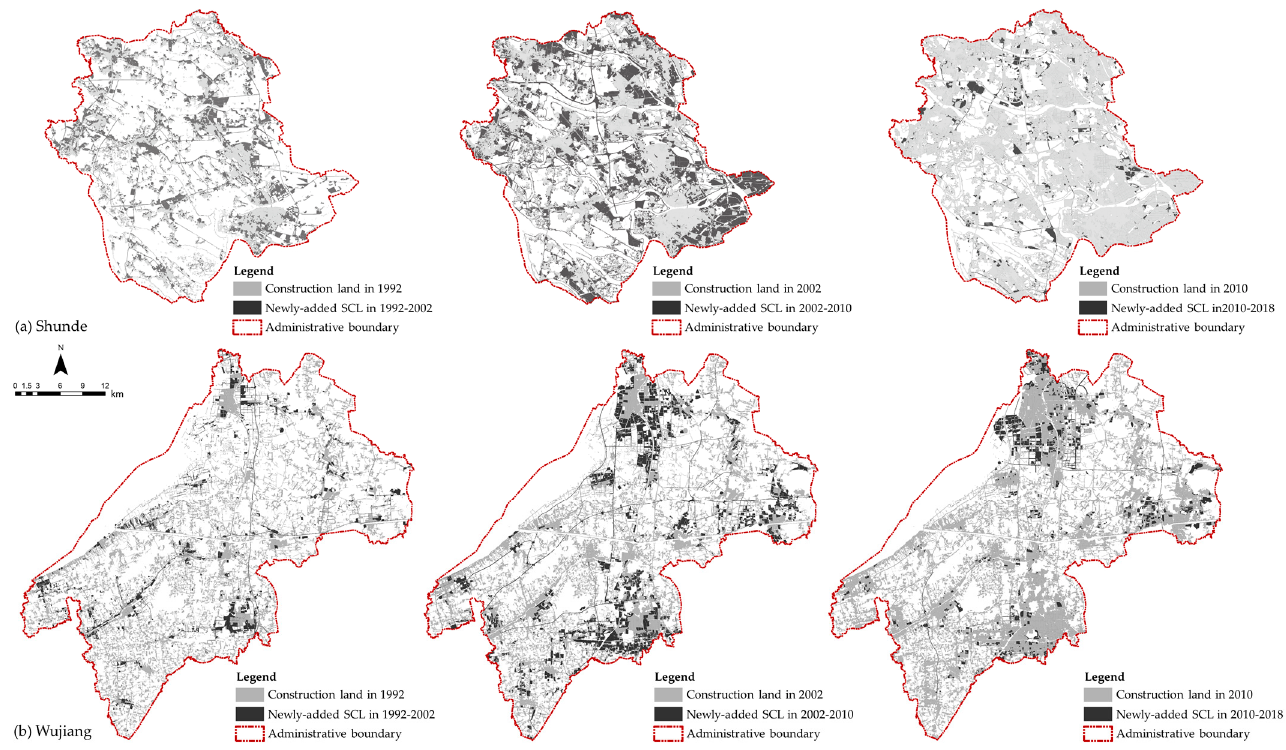
Figure 5. Spatial growth of state-owned construction land of Shunde and Wujiang in 1992–2018. ( a ). Shunde; ( b ). Wujiang.